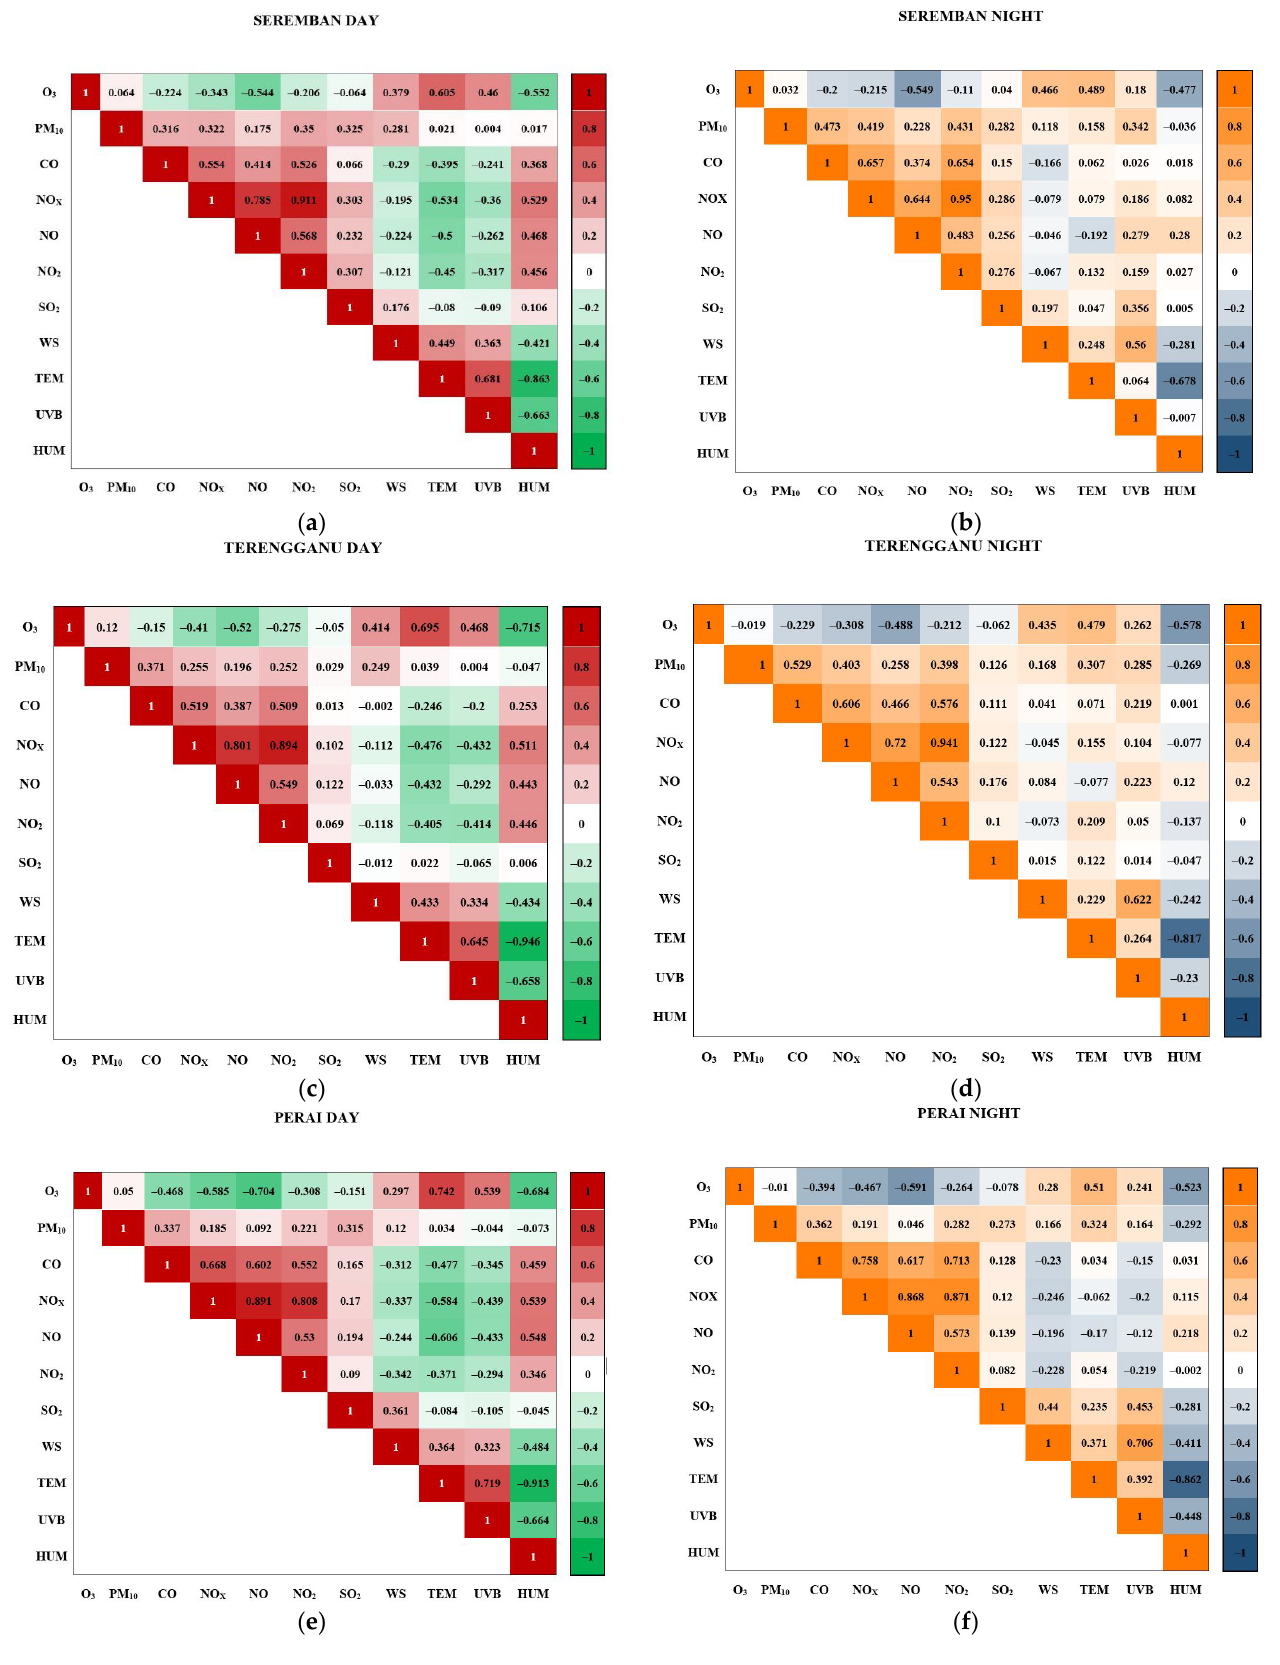
Figure 6. Spearman correlation matrix of O 3 with trace gases and weather parameters: ( a ) Seremban daytime, ( b ) Seremban nighttime, ( c ) Kuala Terengganu daytime, ( d ) Kuala Terengganu nighttime, ( e ) Perai daytime, and ( f ) Perai nighttime.